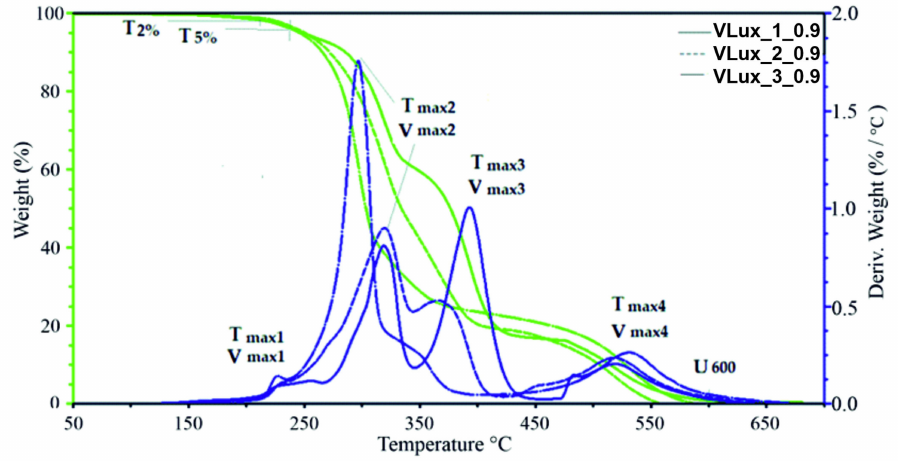
Figure 12. Results of TGA analysis and parameters description for foams with INCO = 0.9 and different water content.